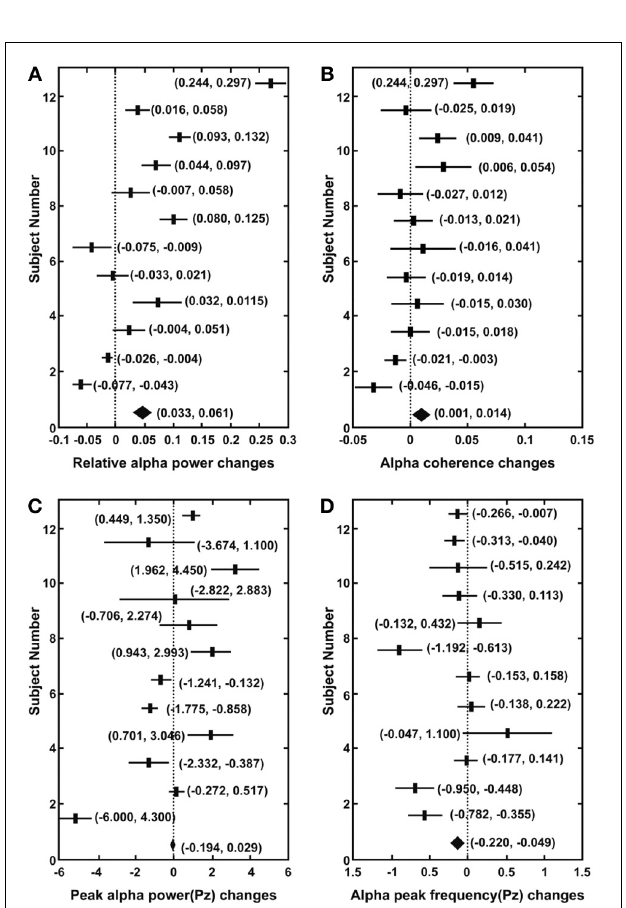
FIGURE 2 | Confidence intervals (95%) for changes in alpha band activities from baseline to during meditation in each participant and in all participants (bottom indicates the result for all participants). (A) Relative alpha power averaged over 19 channels. (B) Alpha band lagged coherence averaged over 171 channel combinations. (C) Parietal peak alpha power (Pz). (D) Parietal peak alpha frequency